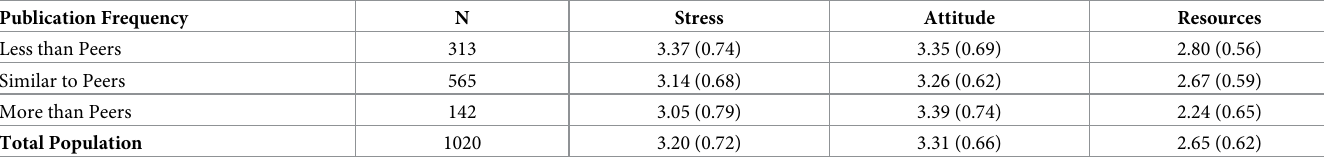
Values represent mean score with standard deviation in